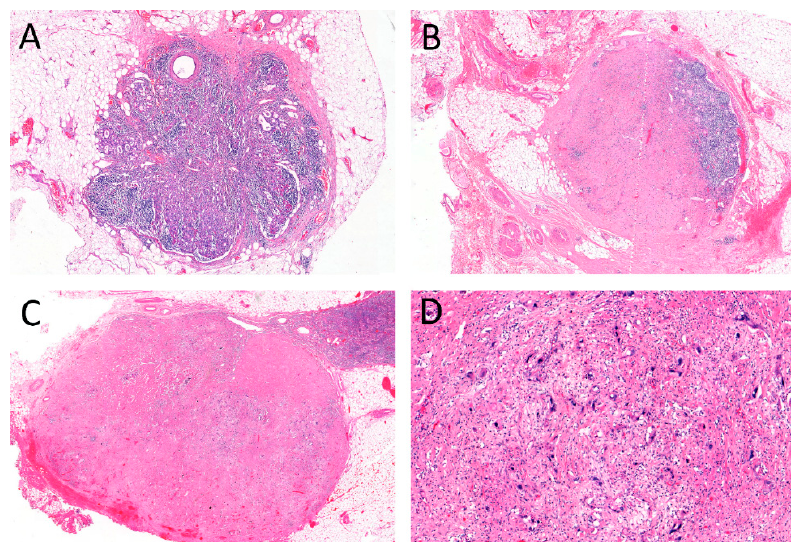
Figure 2. Examples of lymph node metastases (LNM): ( A ) LNM without regression (LN+/REG-); ( B ) LN with completely regressed former metastasis (LN-/REG+); ( C ) LNM with regression and residual tumor (LN+/REG+); higher magnification of ( C ); all images magnification ×10, except ( D ) (×40).